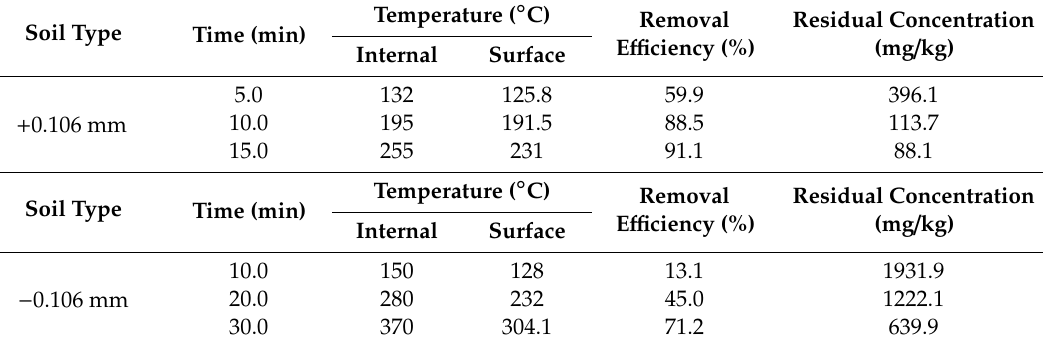
Figure A1. XRD pattern of soil sample. Table A1. Removal efficiency and temperature as a function of time for the different particle size.